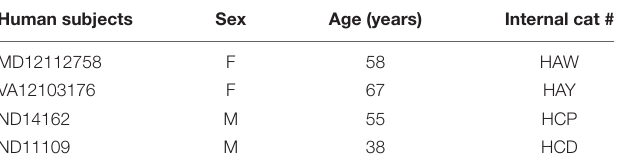
TABLE 1 | Data of human subjects